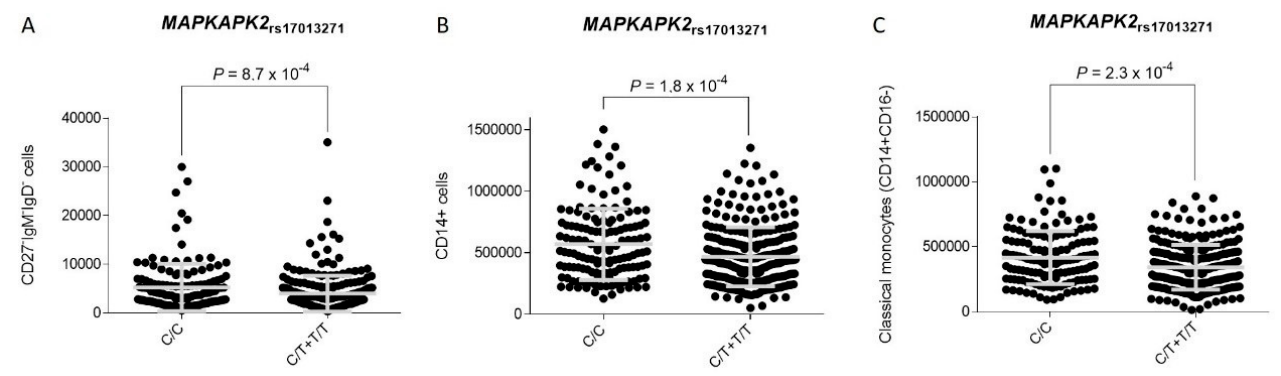
Figure 3. Correlation between the MAPKAPK2 rs17013271 SNP and blood CD27-IgM-IgD- B cells ( A ), blood CD14+ cells ( B ) and classical CD14+CD16- monocytes ( C ).